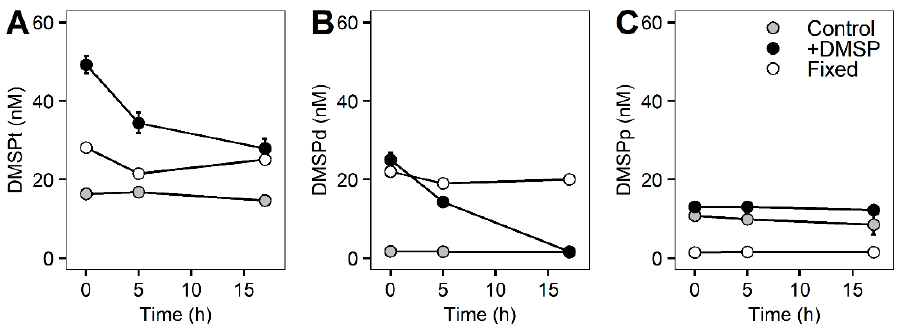
Figure 2. DMSP concentrations of the whole marine microbial community over 17 h. Concentra- tions of DMSPt ( A ), DMSPd ( B ), and DMSPp ( C ) over 17 h for control samples (light grey circles), DMSP-enriched samples (black circles), and fixed samples (white circles).